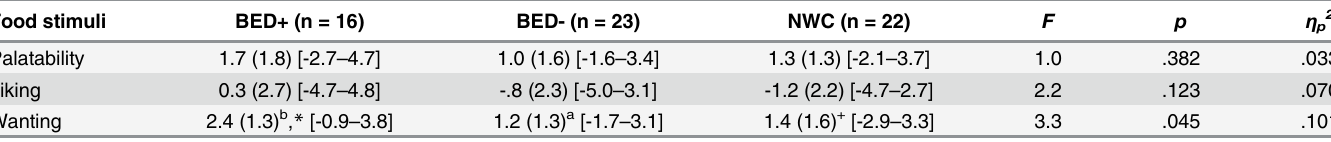
The overall course of muscular response across all three groups can be seen in Fig 3. Regarding the CS activation the repeated measures ANOVA revealed a significant main